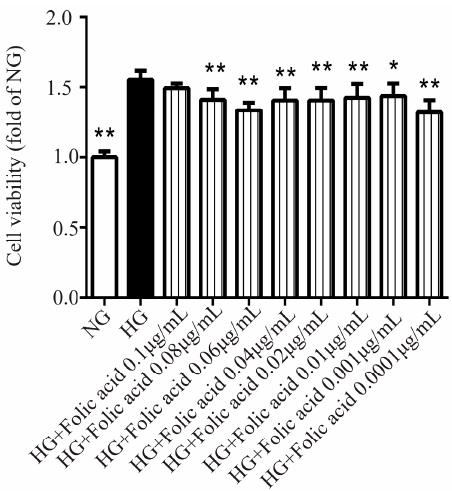
Figure 2. Folic acid inhibited the cell viability of RVECs. The cells (4000 per/well) were treated with HG or various concentrations of folic acid for 72 h. The abbreviation HG represents high glucose, i.e., the cells were cultured in a medium with a glucose concentration at 25 mM. The effect of folic acid (0.1–0.0001 μ g/mL) on RVECs viability was assessed by CCK-8 assay. The data was presented as means ± SD ( n = 5–6). * p < 0.05, ** p < 0.01, compared with HG-treated cells.